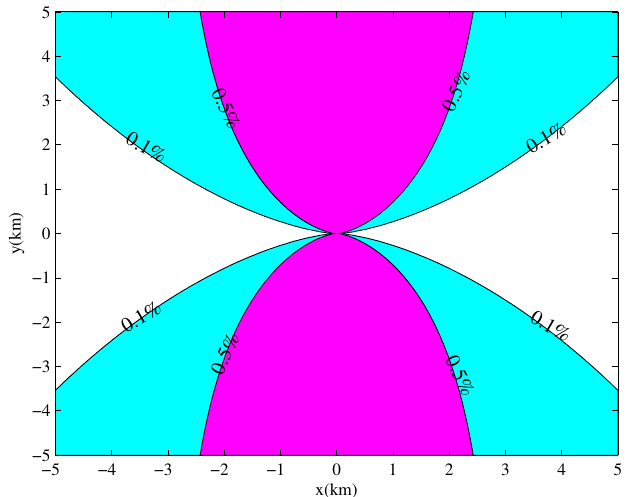
Figure 3. The filled contour plot of the Doppler frequency shift variation with motion type 1.